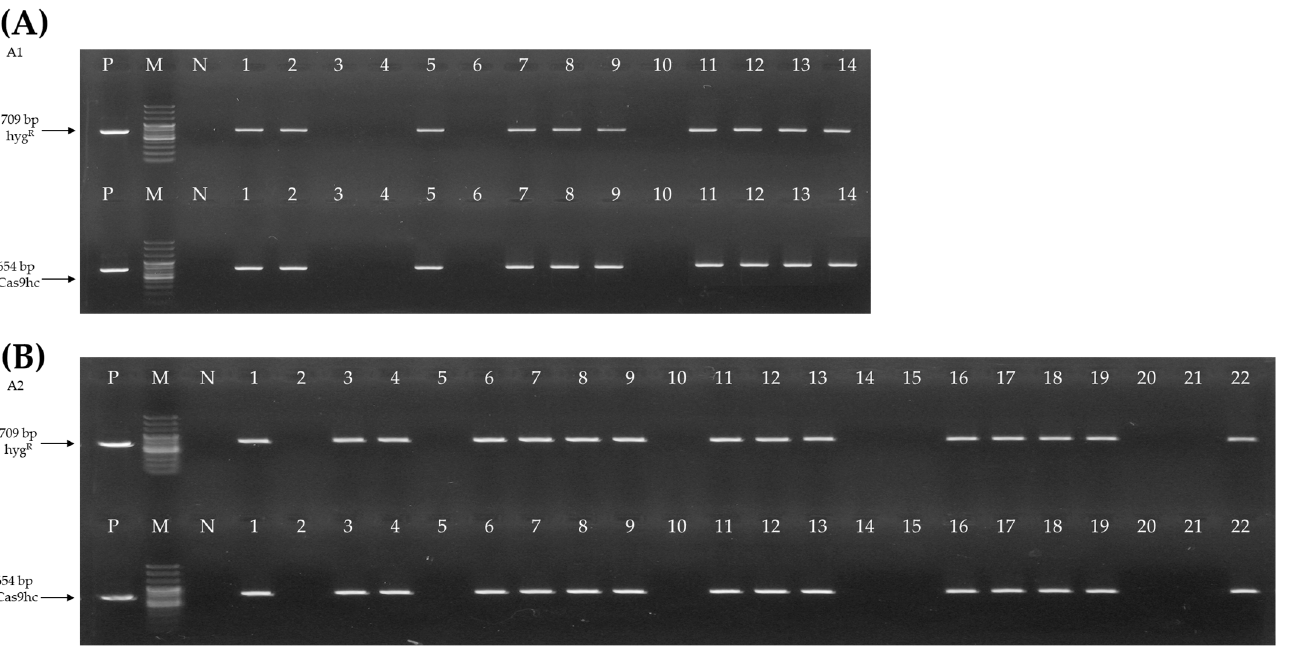
Figure 2. Selection of E 0 AGAMOUS-like (AGL) -edited lines by polymerase chain reaction (PCR) analysis. ( A ) PCR analysis with hyg R and Cas9hc primer sets of E 0 AGL19 -edited lines. ( B ) PCR analysis with hyg R and Cas9hc primer sets of E 0 AGL24 -edited lines. The 709 bp and 654 bp PCR amplicons are indicated with an arrow. P, positive control; M, 100 bp DNA ladder; N, negative control; numbering lane, tentative gene-edited lines.